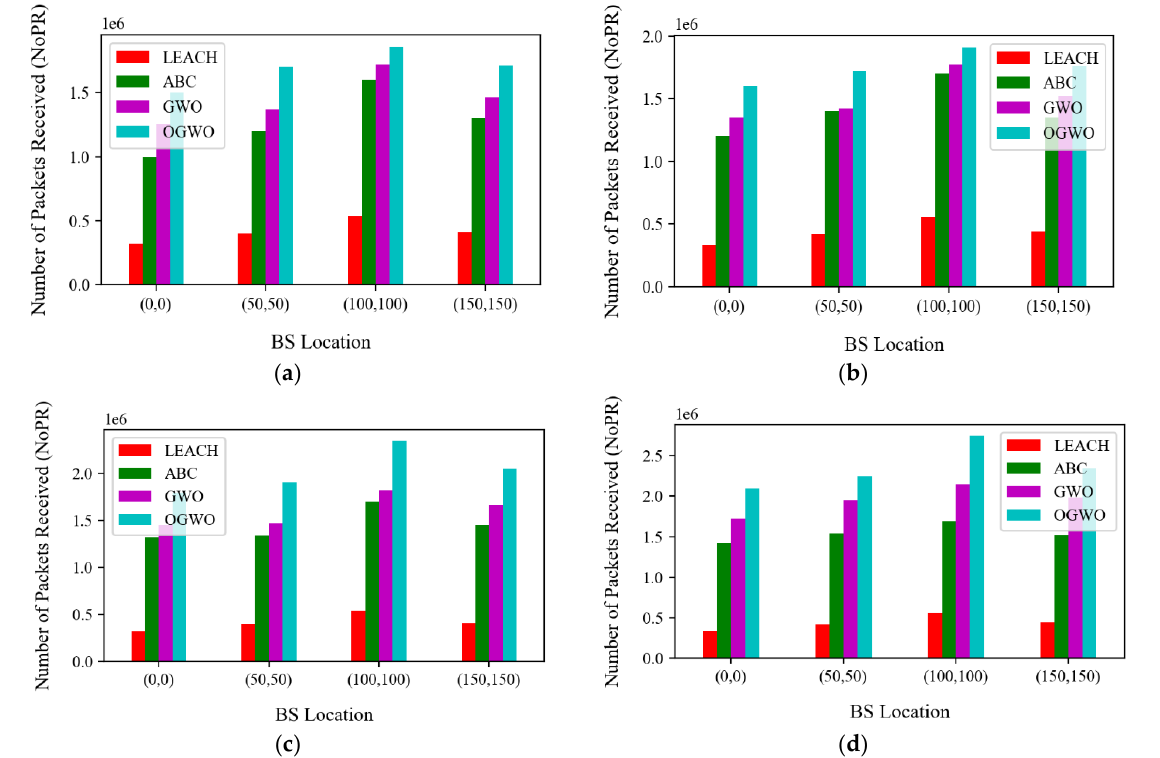
Figure 6. Comparison results of NoPR by BS concerning NCHs = 10%: ( a ) NoPR at NSN = 100, ( b ) NoPR at NSN = 200, ( c ) NoPR at NSN = 300, ( d ) NoPR at NSN = 400.